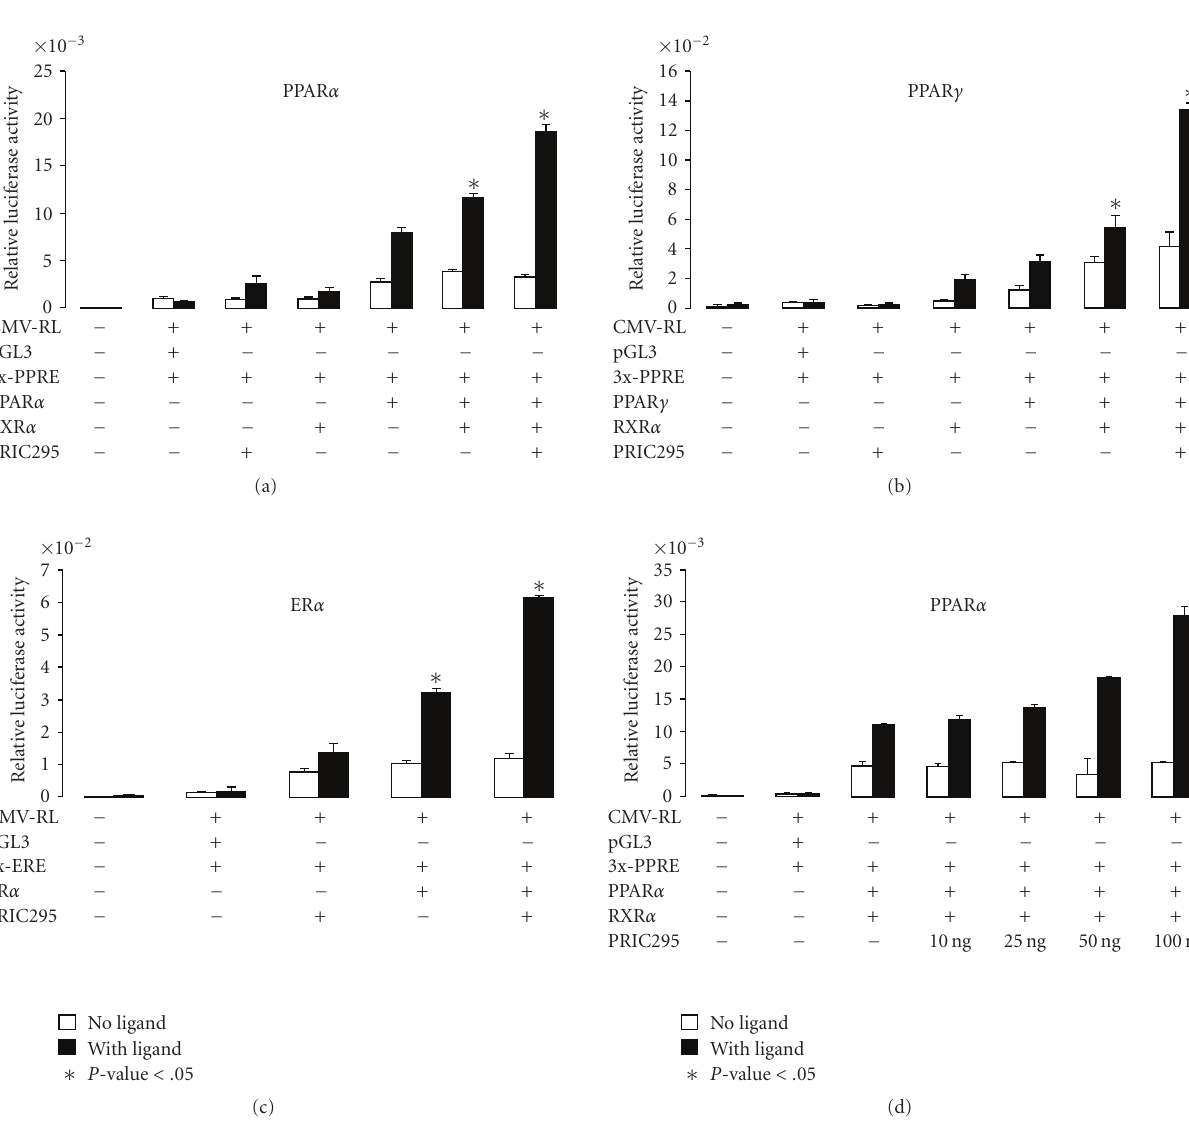
Figure 5: PRIC295 functions as a transcriptional coactivator for nuclear receptors. Data are shown for PPAR α (a), PPAR γ (b), and ER α (c). pGL3-3xPPRE-LUC was used as a reporter for PPAR α and PPAR γ whereas 3xERE was used as reporter for ER α . HeLa cells were transfected with 100ng of pcDNA-PRIC295, pCMX-PPAR α , pCMX-pCMX-PPAR γ , pCMX-ER α , pCMX-RXR α , pGL3-3xPPRE-LUC (or empty pGL3- LUC vector), and 50 ng of CMV-RL plasmid as indicated (+ or − ). Each column shown is the mean relative luciferase unit value for triplicate experiments. Open bar represents activity in the absence and dark bar in the presence of respective ligand (see Figure 4). All experiments were normalized against the expression of Renilla luciferase (CMV-RL) as an internal control. Statistical significance ( P -value) is indicated at the base of the panel and calculated by comparing transfected groups marked with an ∗ . (d) Transcriptional activation of PPAR α with the addition of the increasing amounts of PRIC295. All other plasmids were transfected using the same amounts indicated